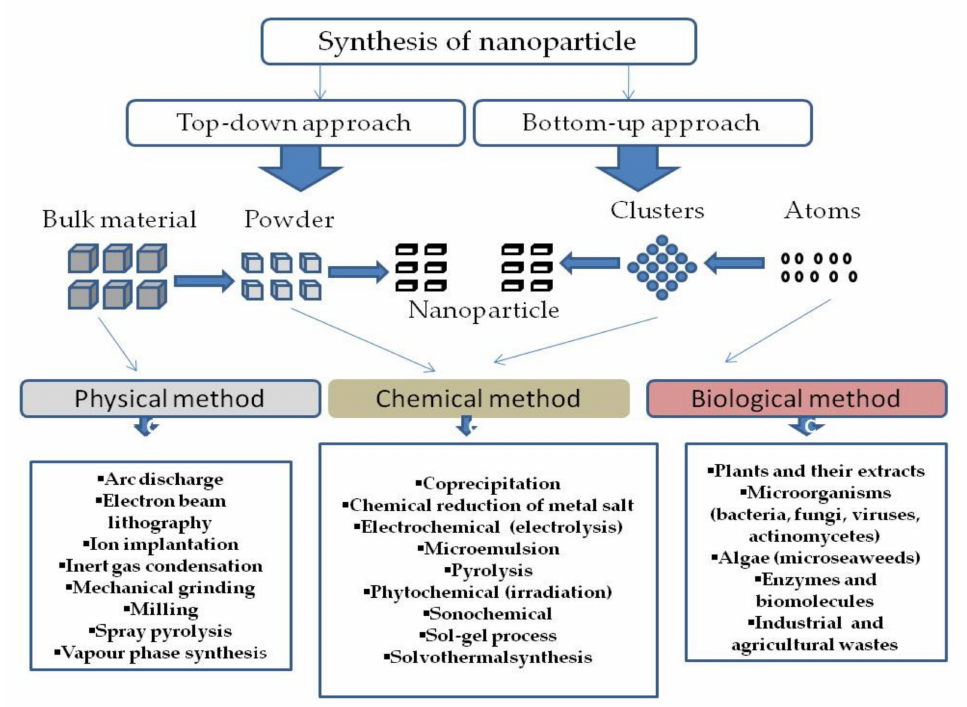
Figure 1. Methods used for the synthesis of MNPs. The different methods are classified as top-down and bottom-up. Adapted from